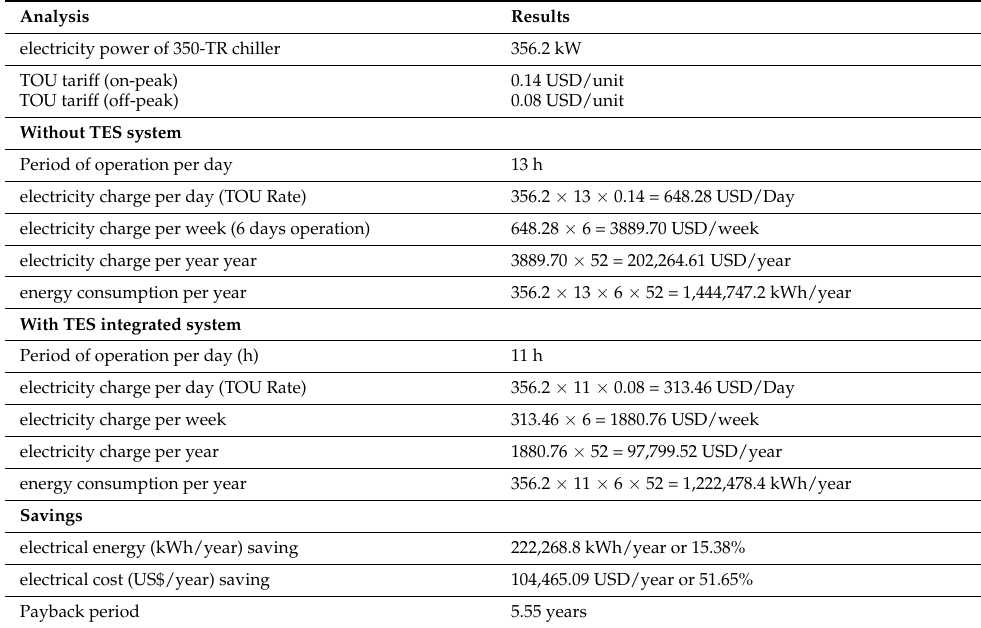
Table 5. Economic analysis summary.